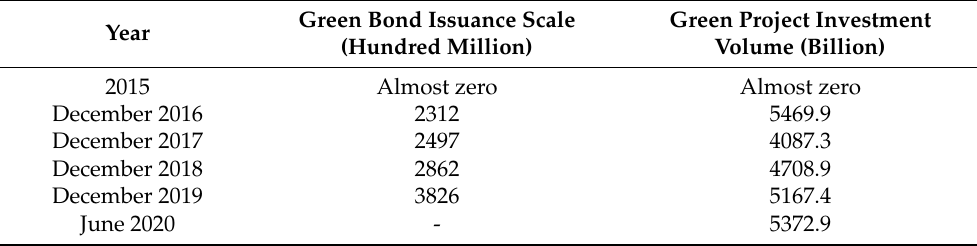
Table 2. China’s green bond issuance scale and green project investment volume from 2015 to 2020.